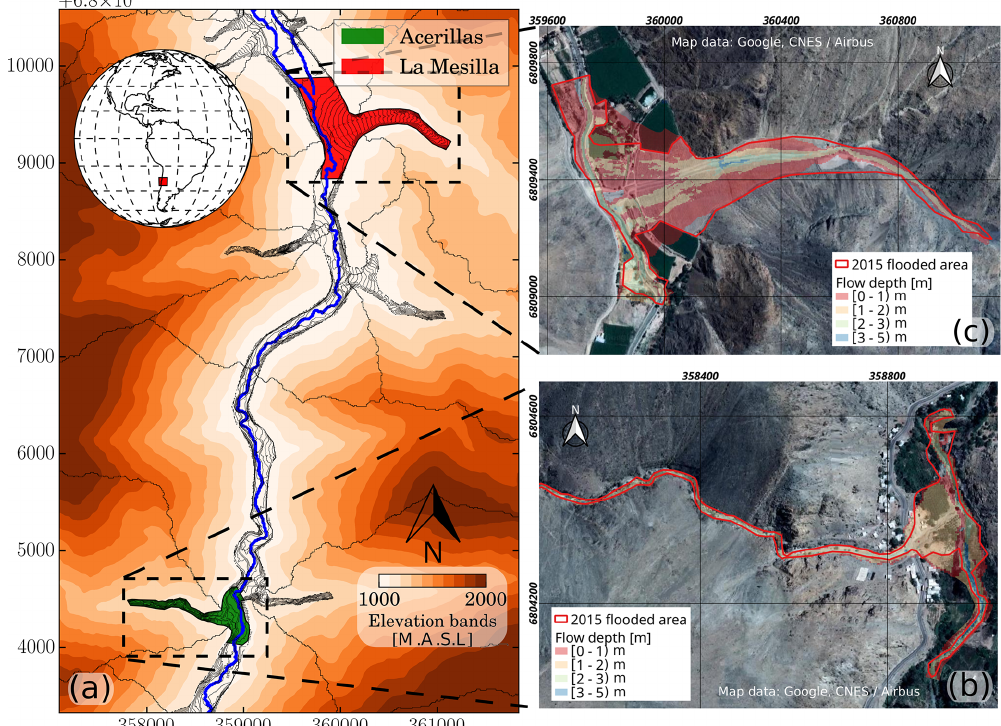
Figure 1. (a) Location of the two case study creeks and reference model results. The maximum observed flood areas and modeled flow depth (reference models) are shown for (b) Acerillas creek and (c) La Mesilla creek. Elevations bands created from a satellite digital elevation model (DEM) at 12 × 12m: © JAXA/METI ALOS PALSAR L1.0 2007 (Japan Aerospace Exploration Agency/Ministry of Economy,